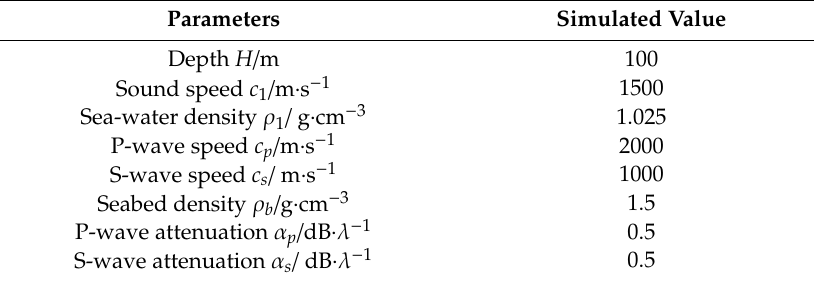
Table 1. The simulation parameters of ocean environment.